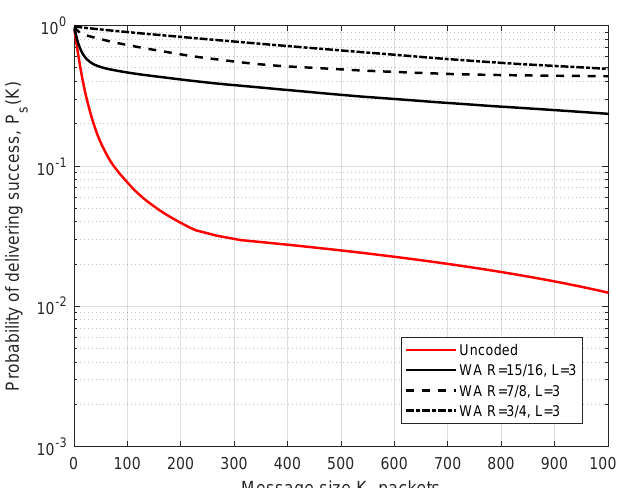
Figure 11. SDF for the production zone. Simulation results for the WA codes of different rates used over production